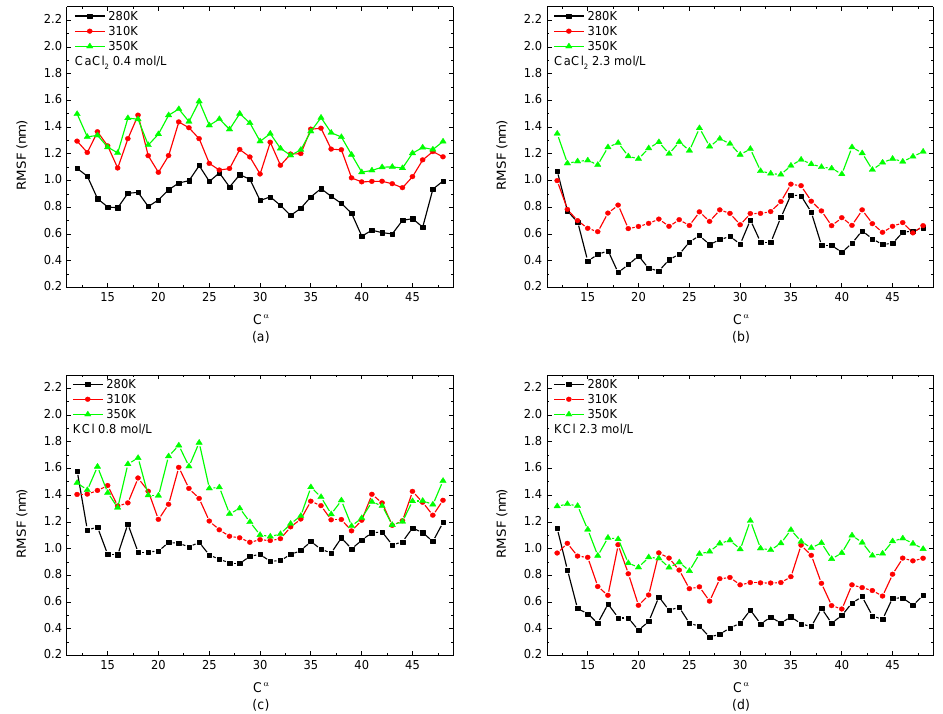
Figure 6. The root mean square fluctuation of the skeleton C α atom of the protein 1BBL immersed in ( a ) 0.4 mol/L CaCl 2 , ( b ) 2.3 mol/L CaCl 2 , ( c ) 0.8 mol/L KClm and ( d ) 2.3 mol/L KCl solutions, respectively.